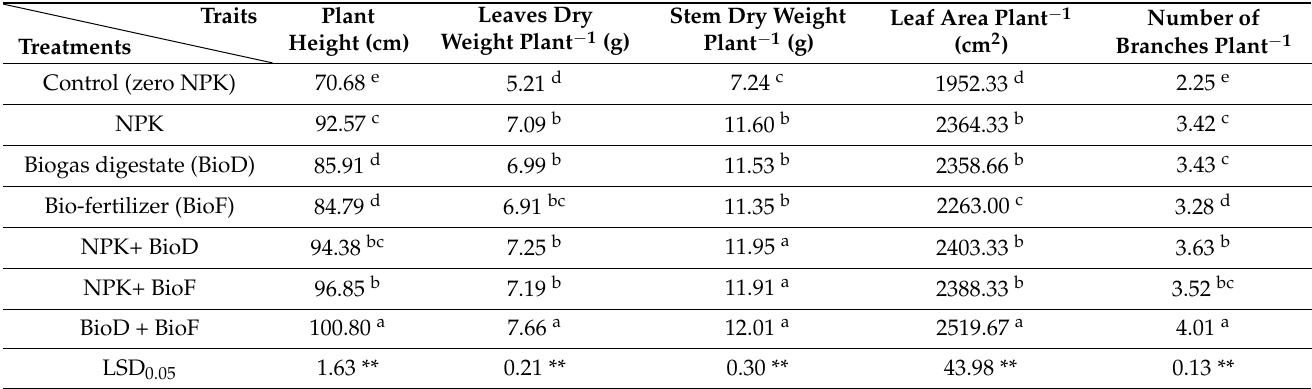
Table 1. Effect of synthetic, organic, and bio-fertilizers on growth traits of faba